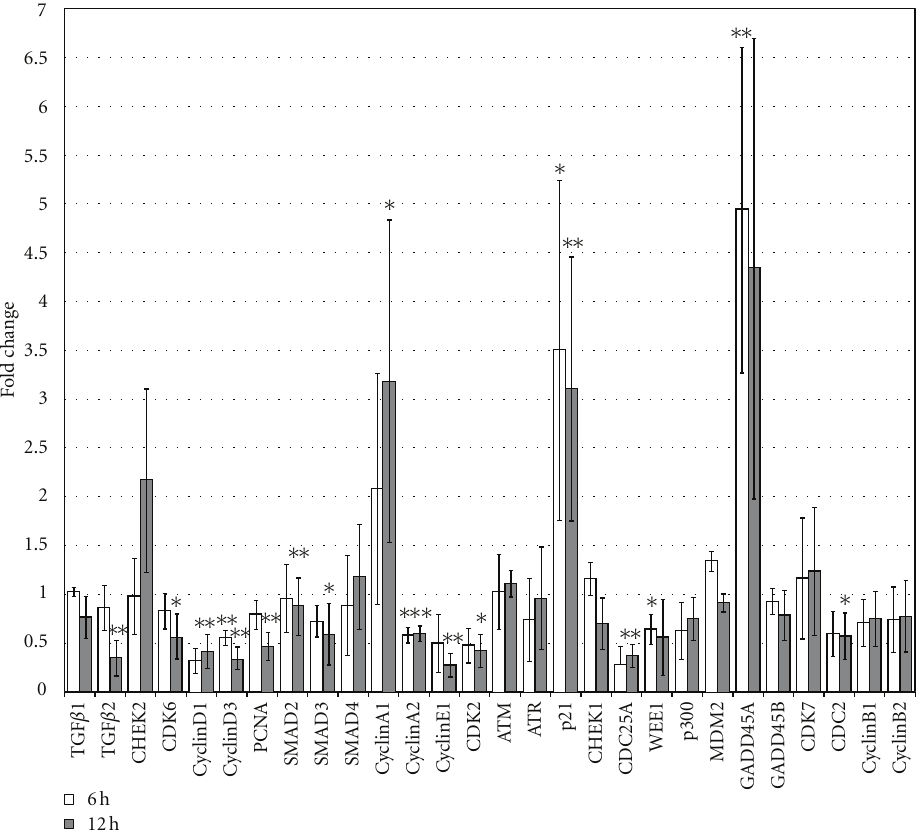
Figure 4: Real-time PCR analysis of gene expression associated with cell cycle. mRNA expression of cell-cycle-related genes, such as cyclins, cdc(s), CDKs, and PCNA, was examined by real-time PCR assay in MDA-MB231 cells after treatment with α -mangostin, as compared with controls. White bars and gray bars show the results of analysis for 6h and 12h after treatment with 20 μ M α -mangostin, respectively ( ∗ P < 0 . 05, ∗∗ P < 0 . 01). Relative levels of target gene expression were calculated using the ΔΔ CT method. GAPDH was used as a reference gene. Data are presented as means ± SD of triplicate independent